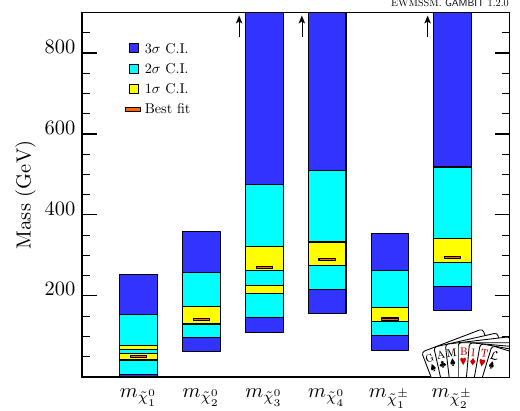
Fig. 5 Summary of the one-dimensional 1 σ , 2 σ and 3 σ confidence intervals for the neutralino and chargino masses. The orange lines mark , m ˜ χ 0 and m ˜ χ ± , the 3 σ confidence intervals the best-fit values. For m ˜ χ 0 3 4 2 extend up to the 2 TeV upper limit on the mass parameters in our